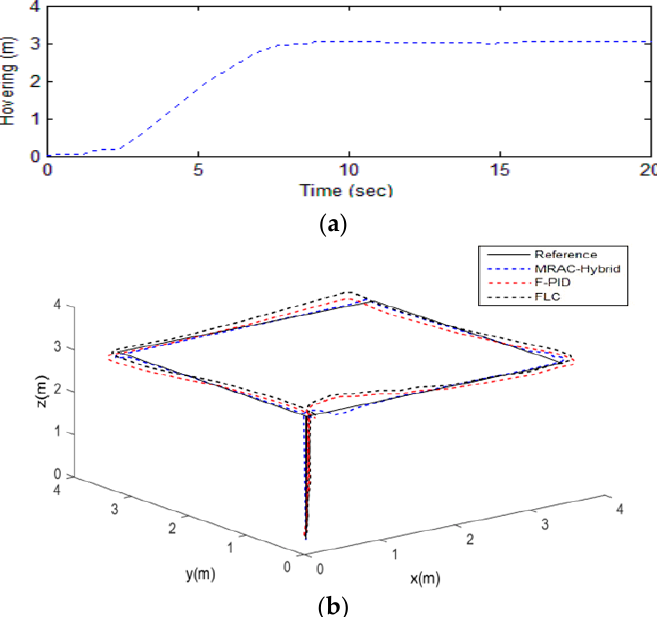
Figure 15. ( a ) Hovering of real flight; ( b ) the 3D diagram of the real flight trajectory tracking of UAV with the reference signal, our proposed approach (the Model Reference Adaptive Control (MRAC)-Hybrid algorithm), the Fuzzy Proportional Integral Derivative (F-PID) approach, and the Fuzzy Logic Controller (FLC) approach.